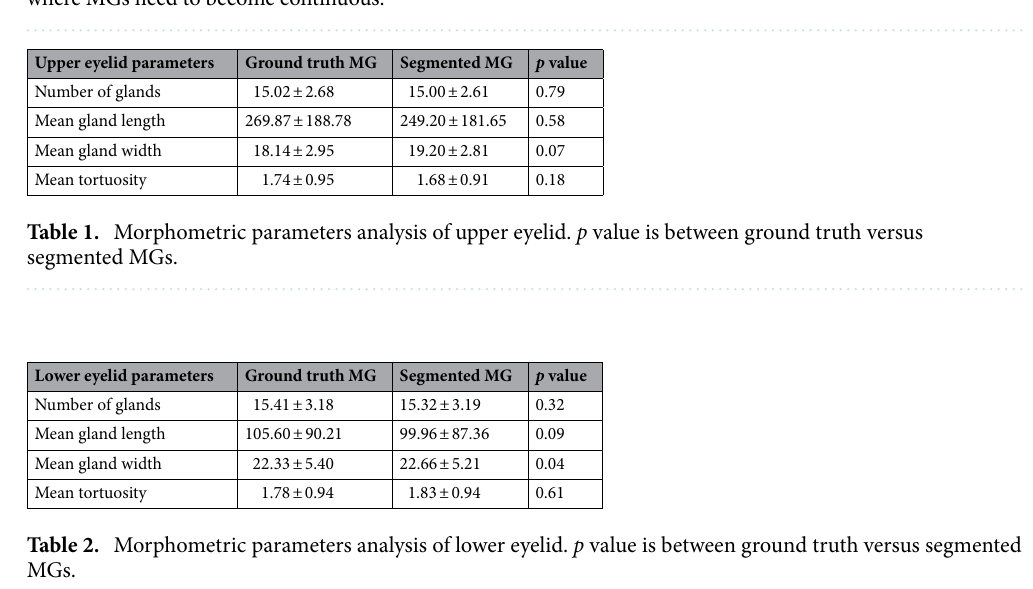
Fig. 6. The total 50 upper eyelid testing images were used for this analysis. The middle solid line indicates the mean of manual and segmented MG which are 0.02, 20.67, − 1.06 and 0.07 for gland number, length, width and tortuosity respectively. All mean values are close to zero, thus the ground truth and automatic segmentation are not significantly different ( p > 0.005). The two dotted lines indicate the limit of agreement (+ 1.96 SD) and the values were in between 1.13 and − 1.09 for gland number, 88.45 and − 47.11 for length, 1.27 and − 3.39 for width and 0.72 and − 0.59 for tortuosity. The gray bar indicates the confidence interval of 95%. Among the all 50 test images only 1, 2, 0, and 3 values were outside the limit of agreement thus the 98%, 96%, 100%, and 94% of the values are within the limit of agreement.